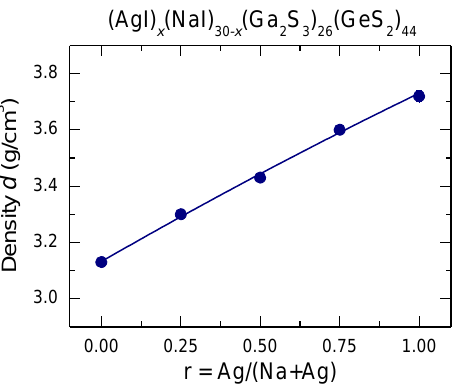
Figure 2. Density of the (AgI) x (NaI) 30 − x (Ga 2 S 3 ) 26 (GeS 2 ) 44 glasses plotted as a function of the silver fraction r = Ag/(Na + Ag). The solid line is drawn as a guide for the eye. Typical DSC curves of the (AgI) x (NaI) 30 − x (Ga 2 S 3 ) 26 (GeS 2 ) 44 glasses, x = 0, 7.5, 15, 22.5,